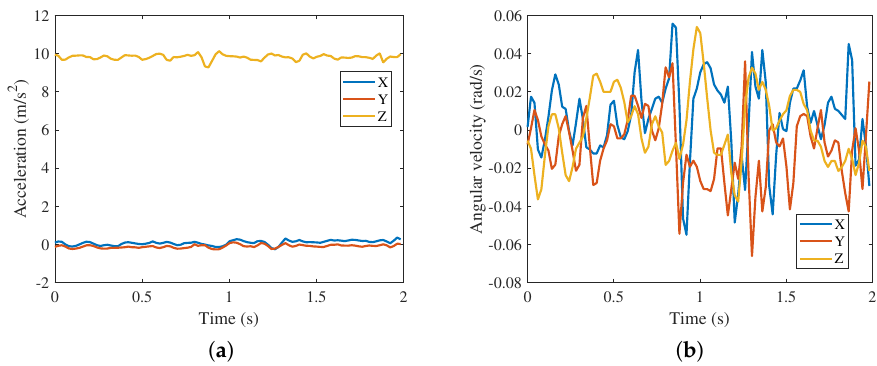
Figure 2. Accelerometers and gyroscopes readings. ( a ) The three-axis acceleration. ( b ) The three-axis angular velocity.